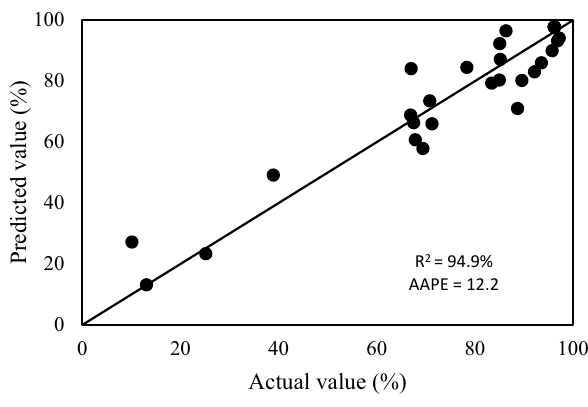
Fig. 3 The actual and predicted values that signify the efficiency of oil removal